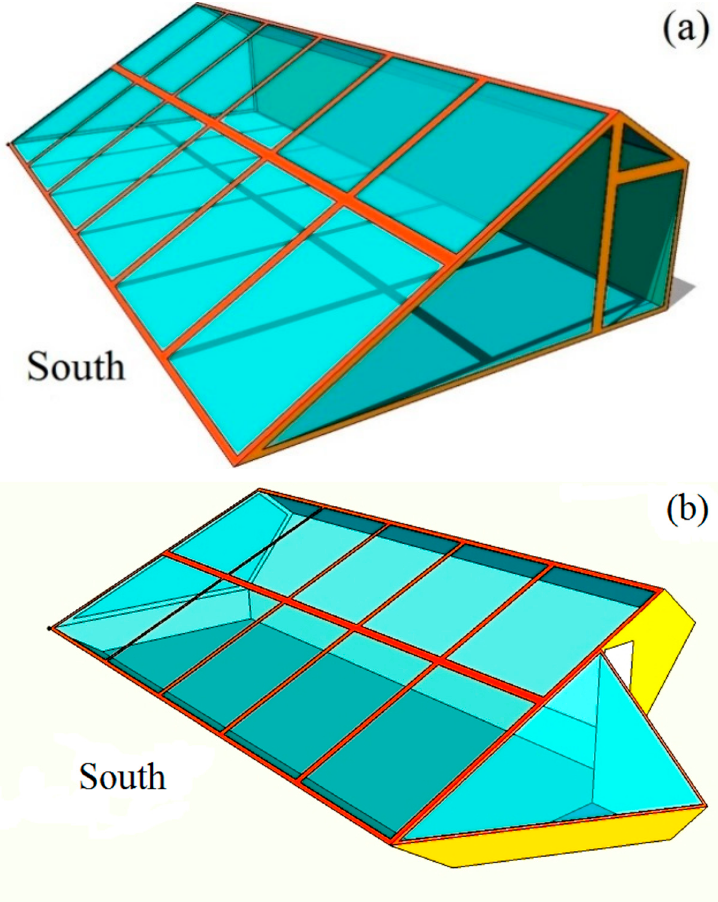
Figure 1. Designs of passive solar conventional ( a ) and optimized greenhouse model ( b ). Table 1. Different employed type of walls for modeling